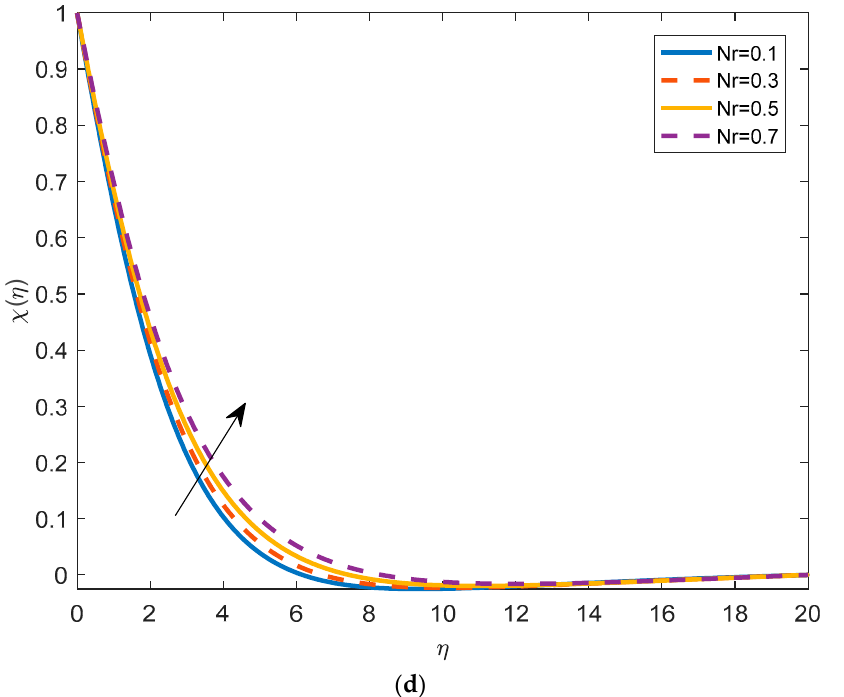
Figure 2. ( a ): Velocity distribution for various Nr when M = 0.1, Rb = 0.1, Nt = 0.1, Nb = 2.0, Pr = 1.5, W e = 0.2, λ = 0.2, Sc = 0.5, Sc n = 0.5, Pe = 1.0 , K p = 0.1 at α = π /6. ( b ): Temperature distribution for various Nr when M = 0.1, Rb = 0.1, Nt = 0.1, Nb = 2.0, Pr = 1.5, W e = 0.2, λ = 0.2, Sc = 0.5, Sc n = 0.5, Pe = 1.0, K p = 0.1 at α = π /6. ( c ): Concentration distribution for various Nr when M = 0.1, R b = 0.1, N t = 0.1, N b = 2.0, Pr =1.5, W e = 0.2, λ = 0.2, Sc = 0.5, Sc n = 0.5, Pe = 1.0, K P = 0.1 at α = π /6. ( d ): Density of motile micro-organisms for various Nr when M = 0.1, Rb = 0.1, Nt = 0.1, Nb = 2.0, Pr = 1.5, W e = 0.2, λ = 0.2, Sc = 0.5, Sc n = 0.5, Pe = 1.0, K p = 0.1 at α = π /6.